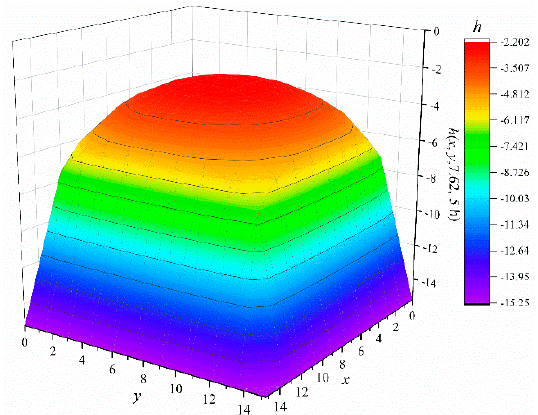
Figure 13. Calculation results at ( , ,7.62,5 h) x y given by the HIM